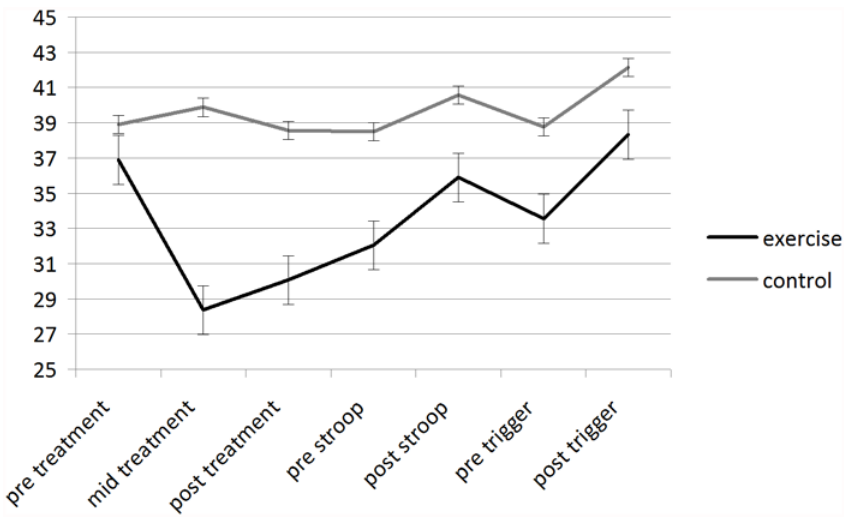
doi:10.1371/journal.pone.0119278.g001